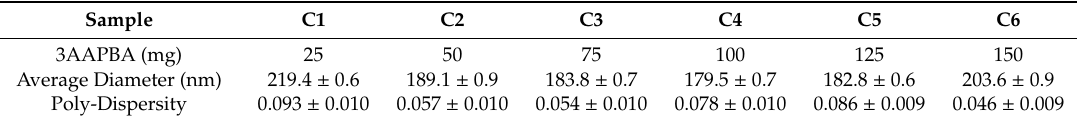
Table 2. Average e ff ective diameter and polydispersity of poly(HEMA) nanoparticles crosslinked with BAC and copolymerized with 3AAPBA. Nanoparticle formulations contained various amounts